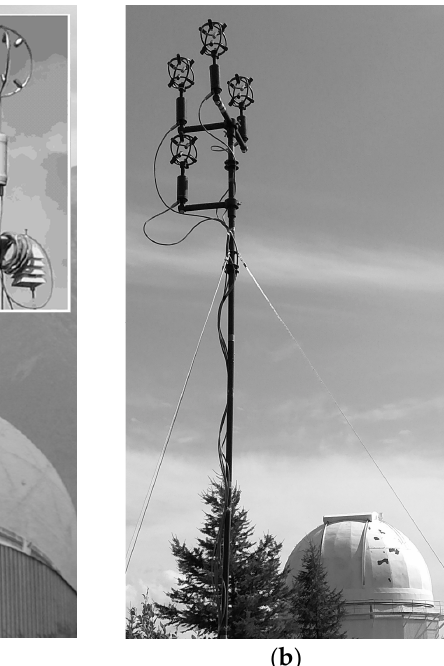
Figure 1. Appearance of the ultrasonic meteorological complexes AMK-03 ( a ) and AMK-03-4 ( b